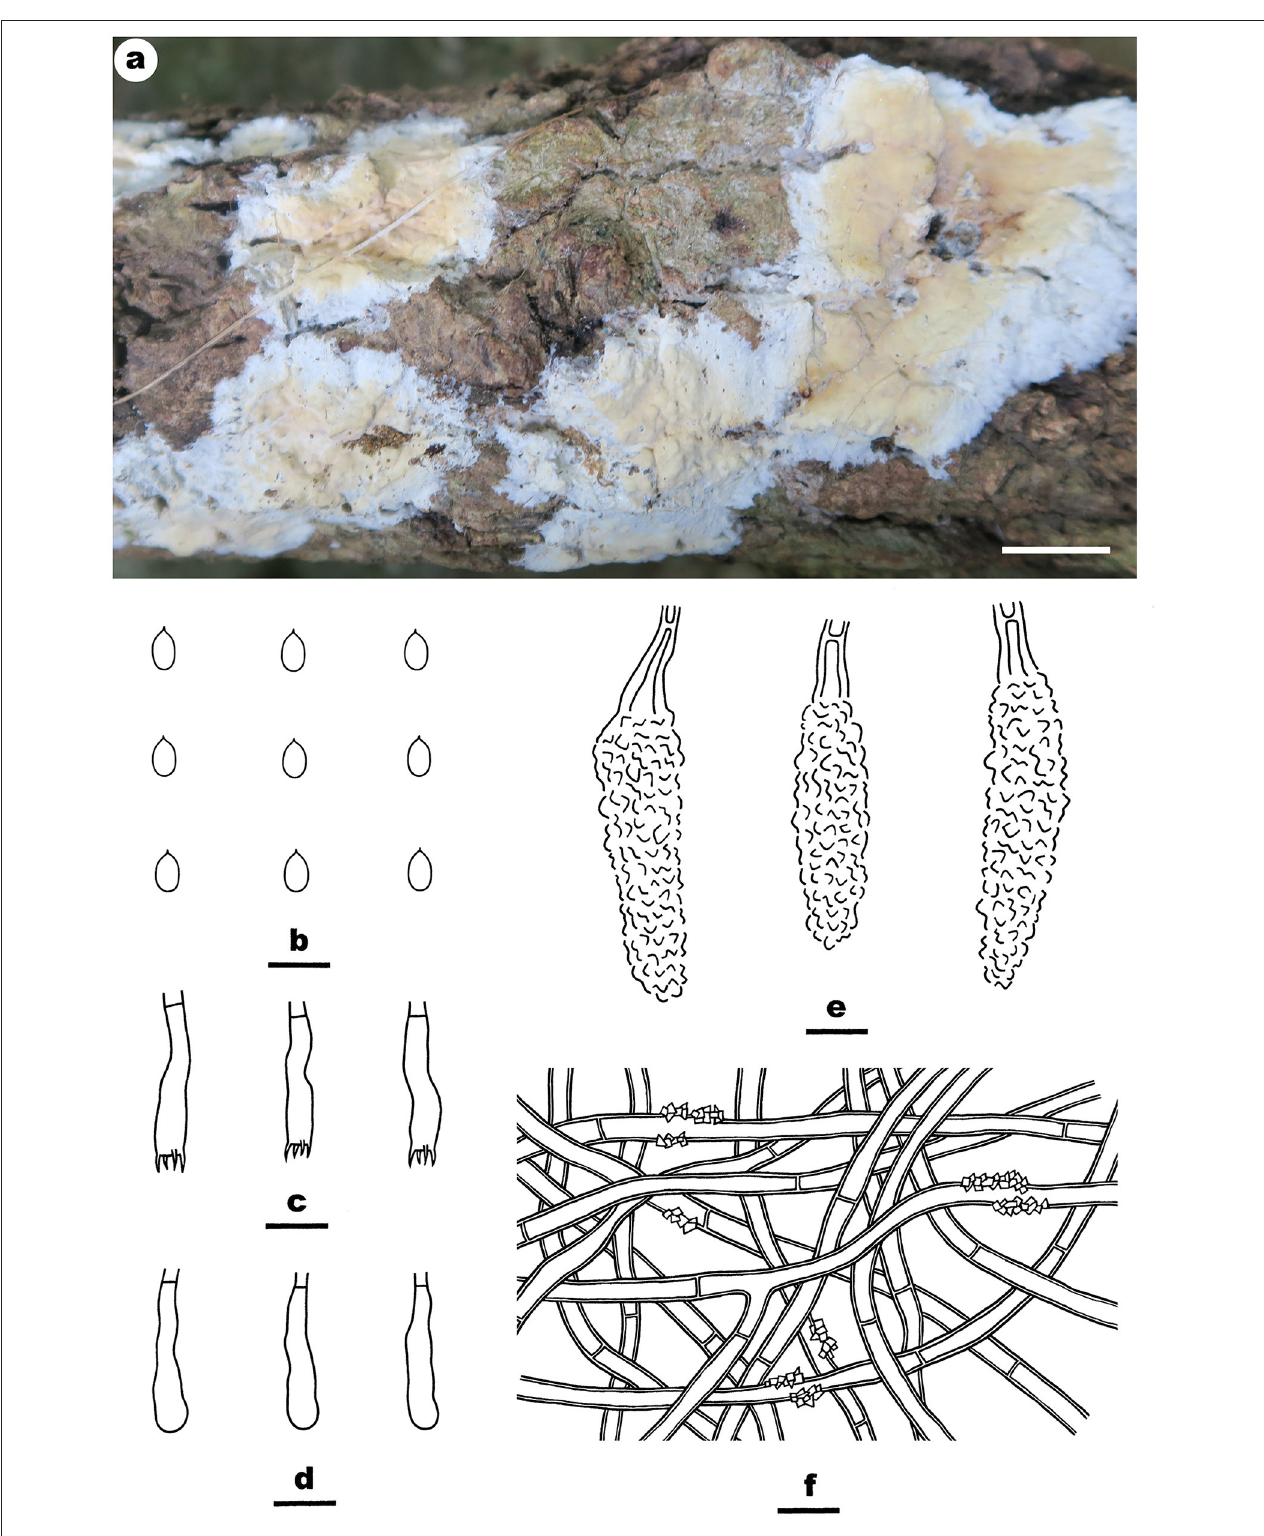
FIGURE 7 | Irpex alboflavescens (from the holotype He 3933; scale bars: a = 1cm; b–f = 10 µ m). (A) Basidiomata. (B) Basidiospores. (C) Basidia. (D) Basidioles. (E) Lamprocystidia. (F) Hyphae from subiculum.